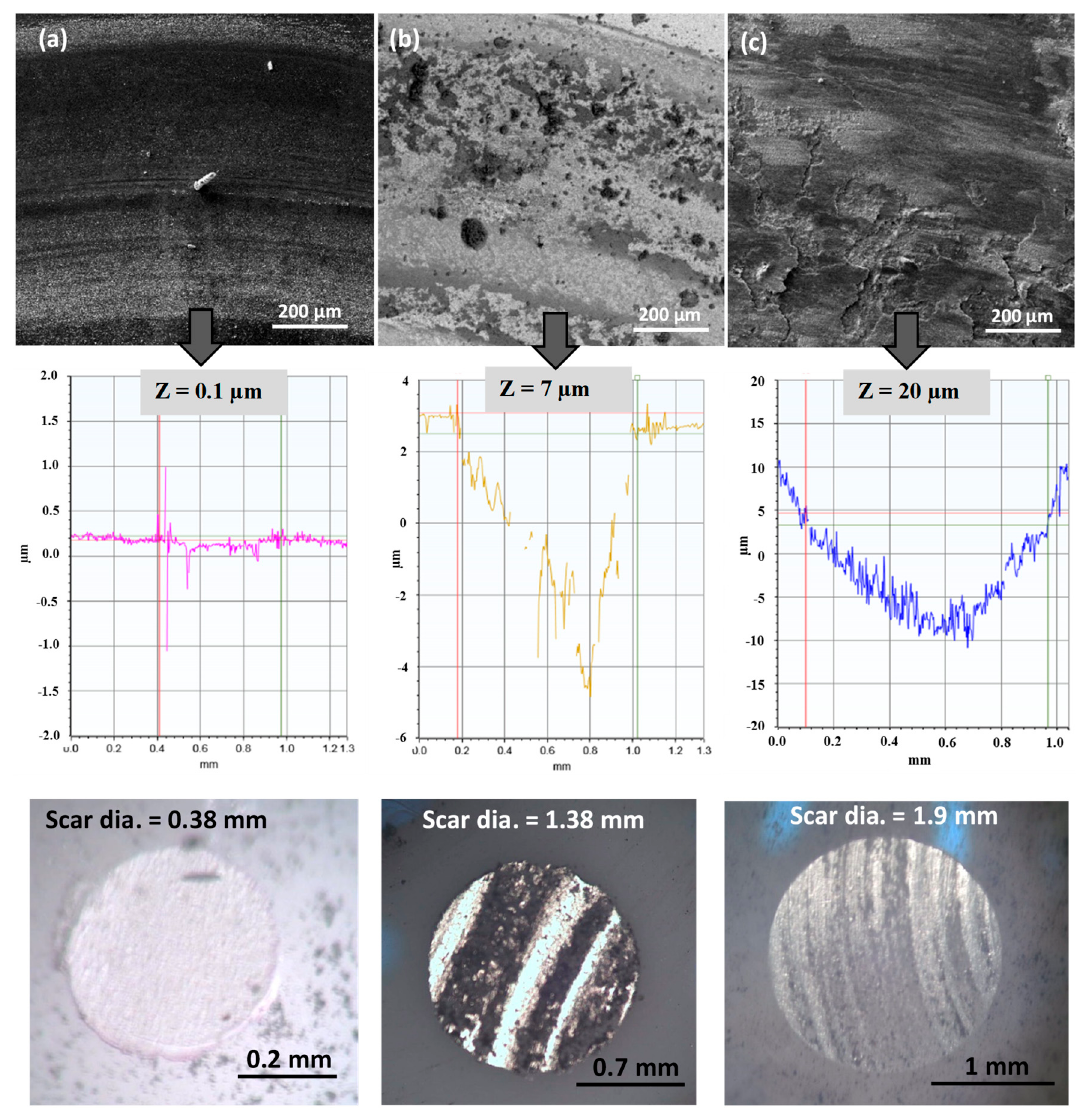
Figure 5. FESEM images, 2D profile plot showing the depth (Z) of the wear tracks and corresponding optical images of the counterface ball revealing the scar diameter of wear test conducted at ( a ) RT, ( b ) 300 °C and ( c ) 600 °C, for the nano-sized WC samples.